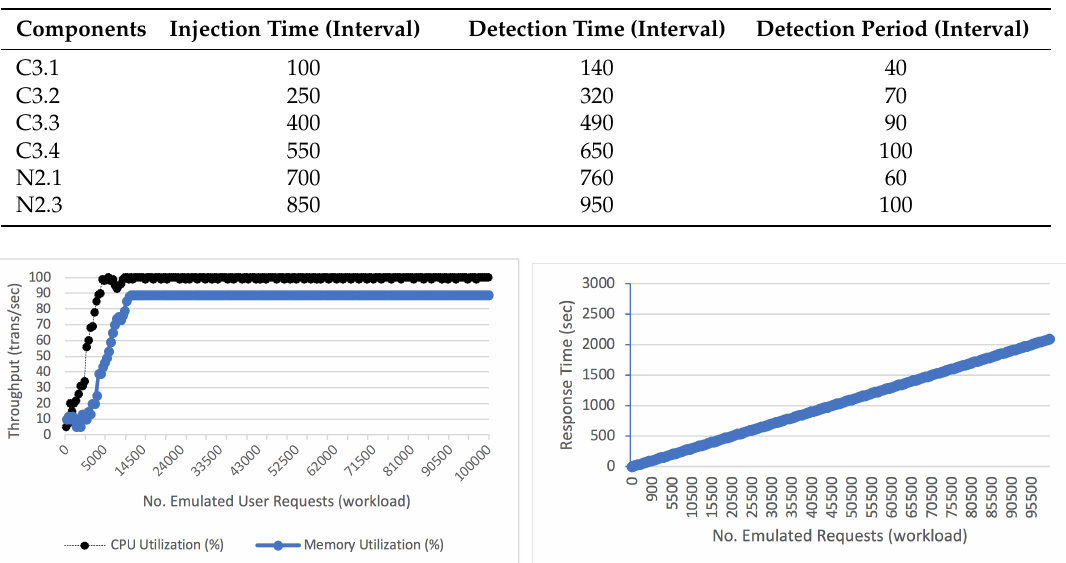
Table 7. Memory leak detection using HHMM.